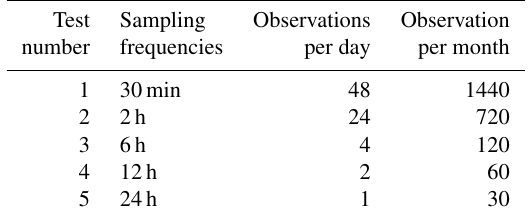
Table 5. Sampling frequencies for Experiment